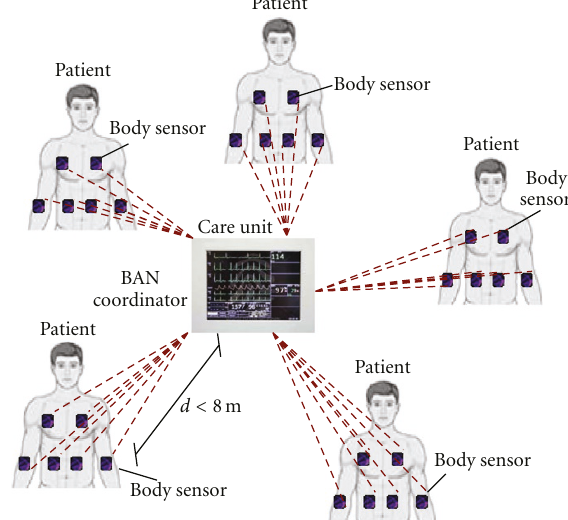
Figure 1: A star-based BSN in a healthcare scenario.